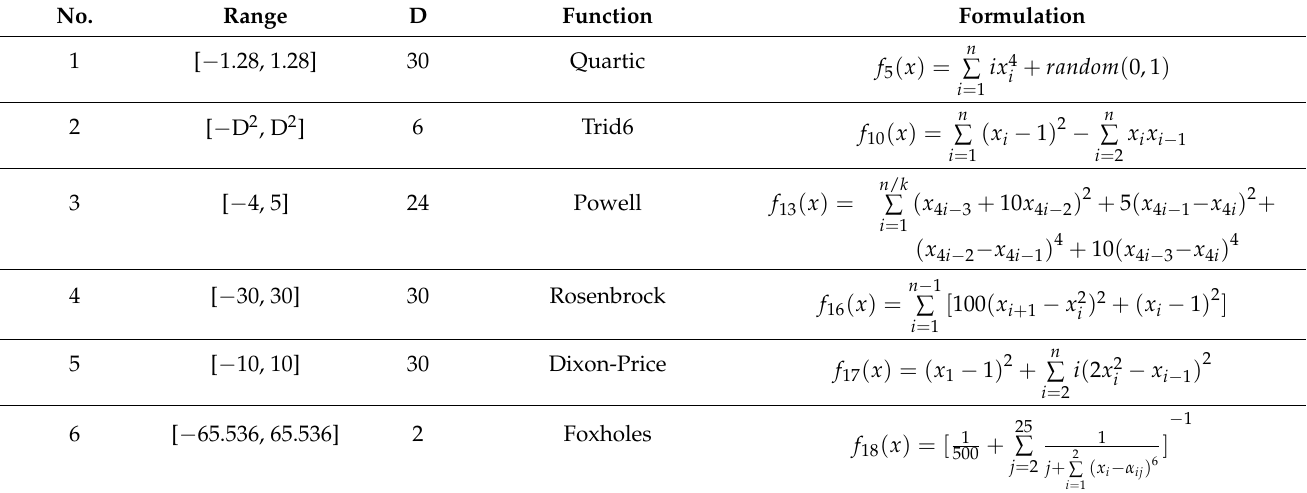
Table 1. The mathematical detailed of employed benchmark